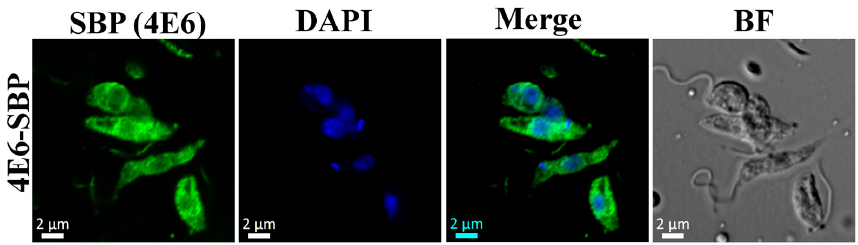
Figure 2. SBP tagged LeishIF4E-6 localizes in the cytoplasm. Transgenic L. amazonensis promastigotes overexpressing SBP-tagged LeishIF4E-6 were fixed and processed for confocal microscopy. LeishIF4E-6-SBP was detected using a monoclonal antibody against the SBP tag and secondary DyLight-labeled antibodies (488 nm; green, SBP). Nuclear and kinetoplast DNA was stained using DAPI (blue). A bright field (BF) picture of the cells is shown on the right. The confocal analysis was repeated three times.